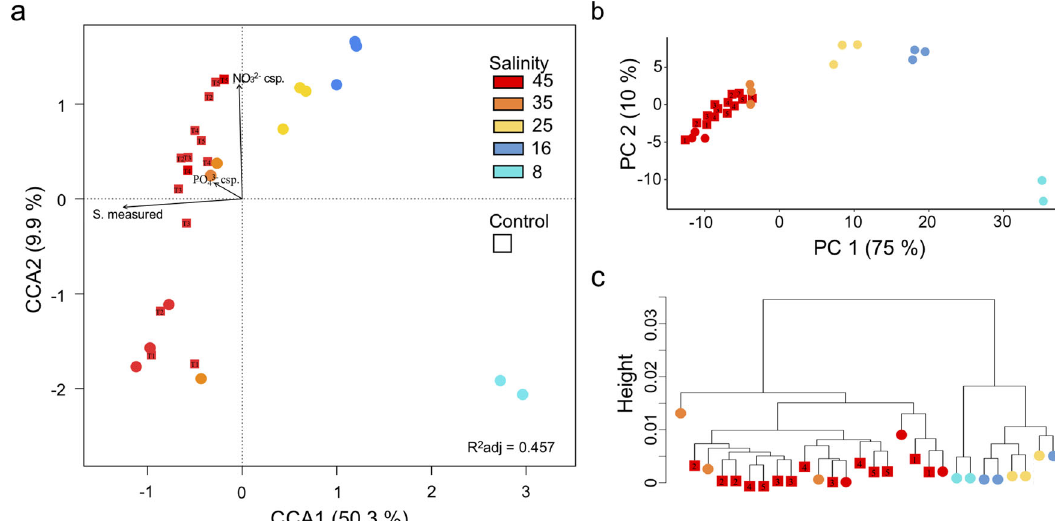
Fig. 1 Clustering of transcriptome samples with normalized reads counts. Experimental salinity values are indicated by colored circles, with S.45 controls as red squares. The number in each square represents the time of sampling (tc1 to tc5). a CCA with the Bray-Curtis dissimilarity measure of reads per gene of all samples. Arrows indicate signi fi cant correlations between culture conditions and samples of each salinity (S). b Transcriptome reads per gene transformed to a differential gene expression matrix and clustered using Principal Component Analysis (PCA) and c dendrogram was constructed using the complete linkage method from stats package on